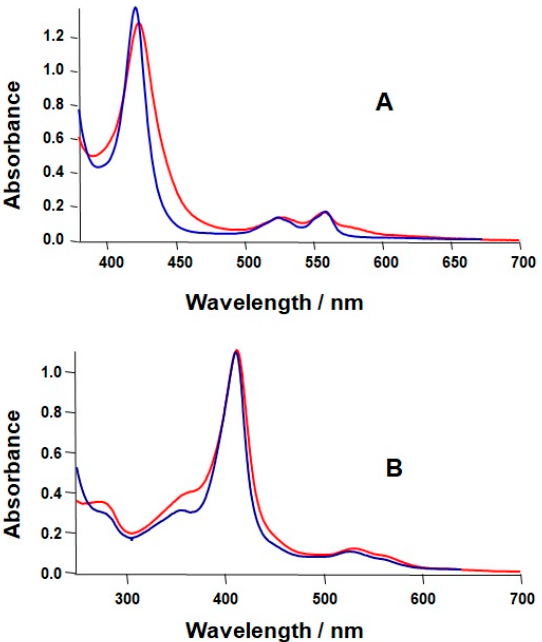
Figure 1. The UV-Vis spectra of the C14A mutant reconstituted with ( A ) ferrous and ( B ) ferric heme b . The spectra immediately after the reconstitution (red lines) show progressive blue shifts (blue lines) under ambient conditions.